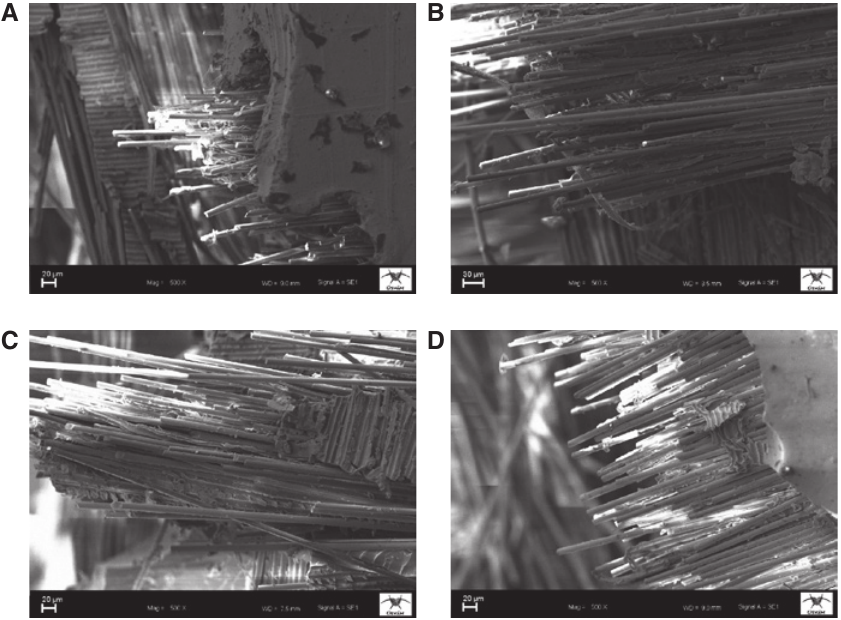
Figure 3: The SEM images of the composite samples. (A) Basalt/epoxy, control, (B) 0.1 wt%, (C) 0.2 wt%, (D) 0.3